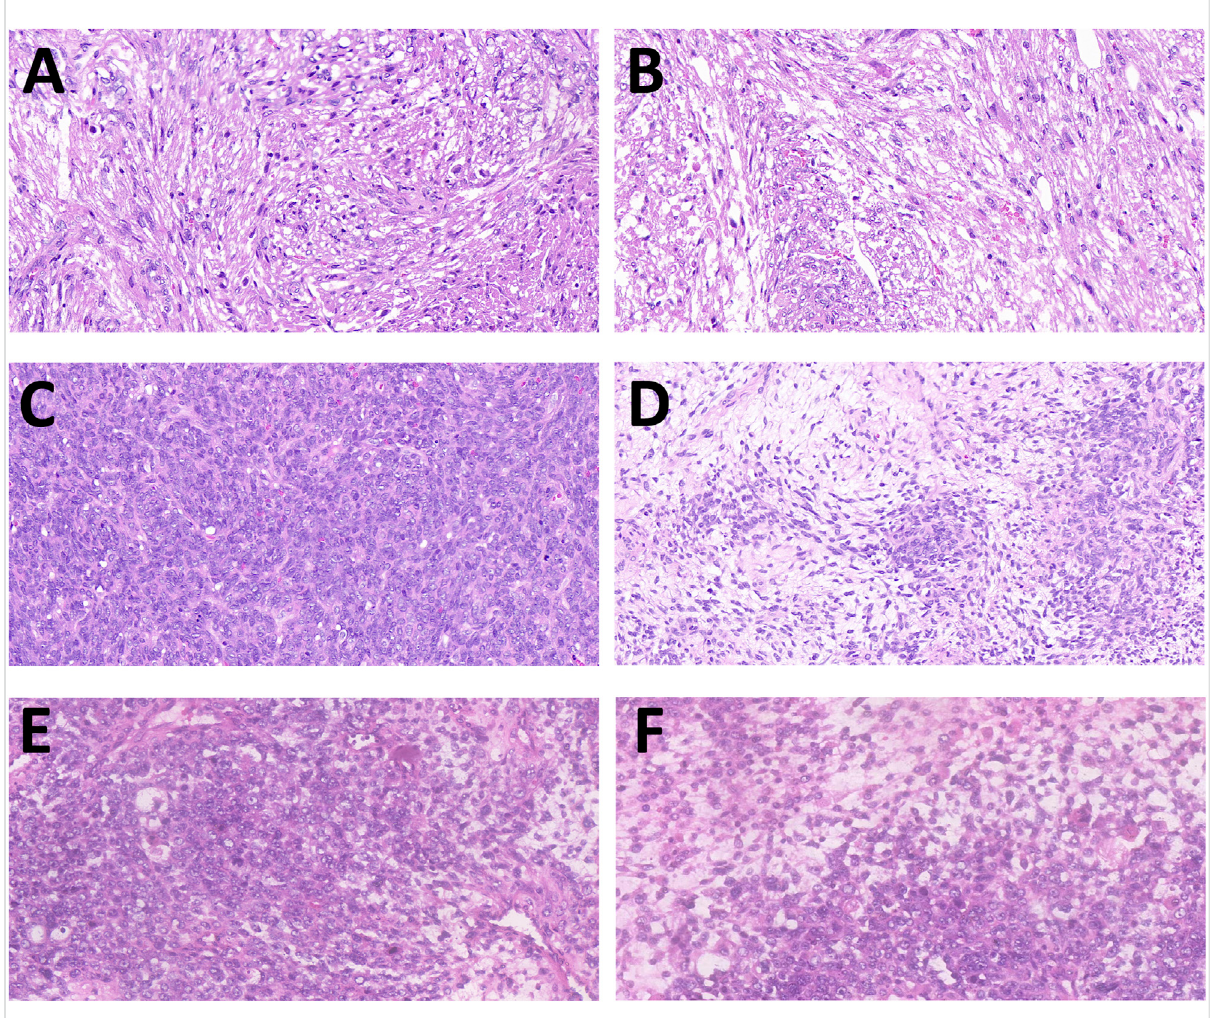
FIGURE 1 Hematoxylin and eosin staining of the three histologic variants of synovial sarcoma (SS). (A,B) Slides of monophasic SS, made of spindle cells with moderate cytologic atypia and differentiated areas of variable cellularity. (C,D) Slides of biphasic SS composed by glandular-like structures with spindle cells without nuclear atypia. (E,F) Slides of poorly differentiated SS in its Ewing-like variant, with the presence of rosette-like structures (magni fi cation: